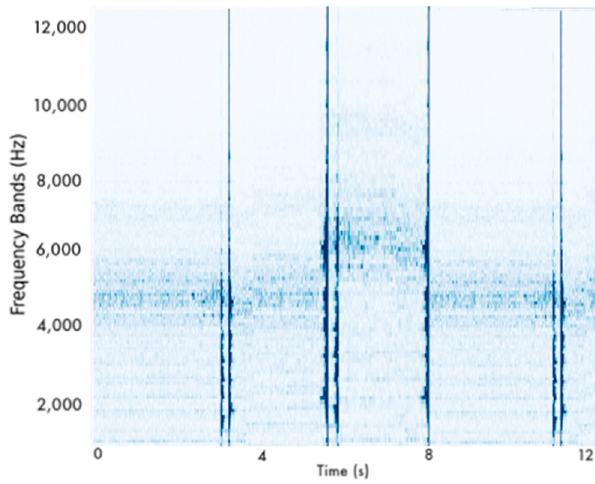
Figure 11. Example of a defective spectrogram extracted from Kalochori dataset.